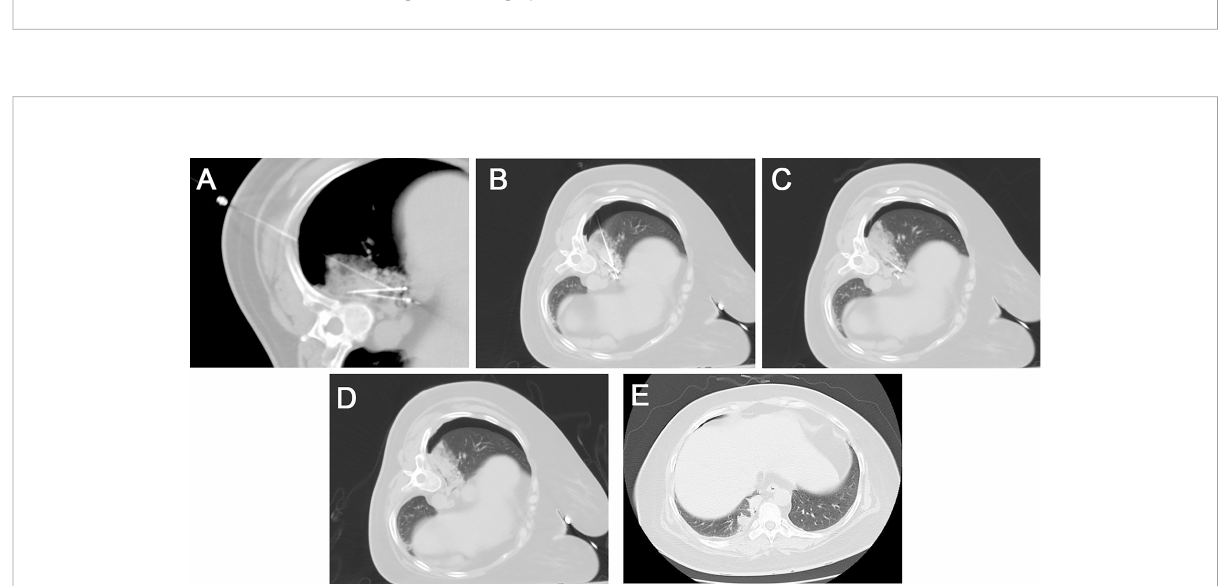
FIGURE 2 (A) Under CT guidance, the radiofrequency ablation probes (long arrow) were placed for the two lesions, and local nerve block anesthesia (short arrow) was performed using a 21G Chiba needle to the diaphragm. (B) A semi-automatic biopsy was used to obtain the tumor tissue from one of the lesions. (C) A scan was performed after 12 min of ablation with a power of 30 w, showing the formation of a halo sign around the lesion. (D) After removing the needle and probes, the CT scan showed substantial localized changes in the ablation zone. A small amount of bleeding from the puncture needle tract with a small amount of pneumothorax on the right side. (E) A follow-up one week after the operation showed a well-de fi ned solid area in the ablation